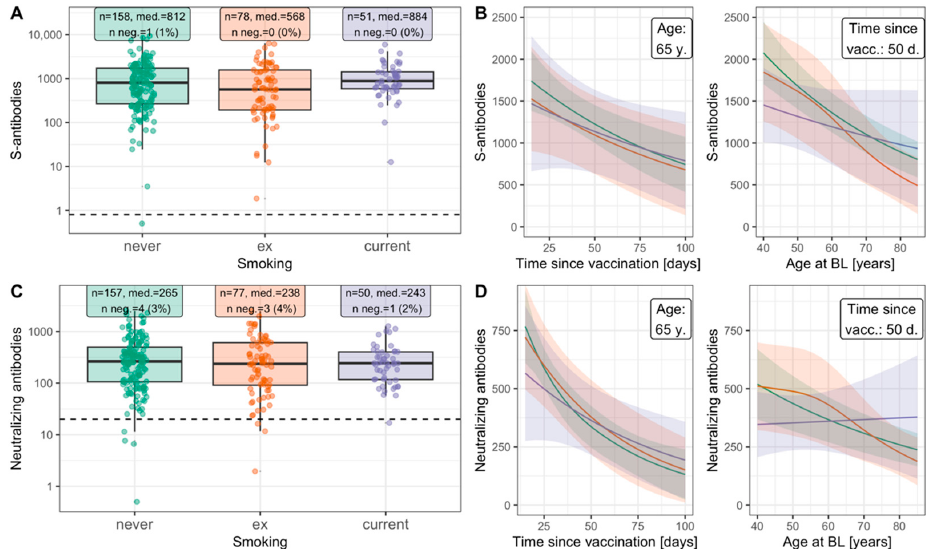
Figure 3. Quantitative antibody levels after vaccination by smoking status among uninfected. Shown are results regarding S-specific and neutralizing antibodies at FU2 among fully vaccinated individuals (i.e., second vaccination more than 14 days before blood draw) who were N-seronegative at FU2 (n = 287, including 51 current smokers). Panels ( A , C ): measured levels (dotted line = threshold for binary seropositivity), sample size, median antibody level, number (%) of individuals seronegative for the respective antibodies. Panels ( B , D ): expected antibody levels from a generalized additive model with covariates age (non-linear), time since vaccination (non-linear) and smoking status including interactions with age and time since vaccination. We did not find evidence for associations of expected antibodies with smoking status (Approximate F-test comparing this model to the corresponding model without smoking status and interactions: p = 0.274 and p = 0.266 for S-specific and neutralizing antibodies). S-specific antibodies: Binding Antibody Units (BAU)/mL; Neutralizing antibodies: Inhibitory Dose 50 (ID50).